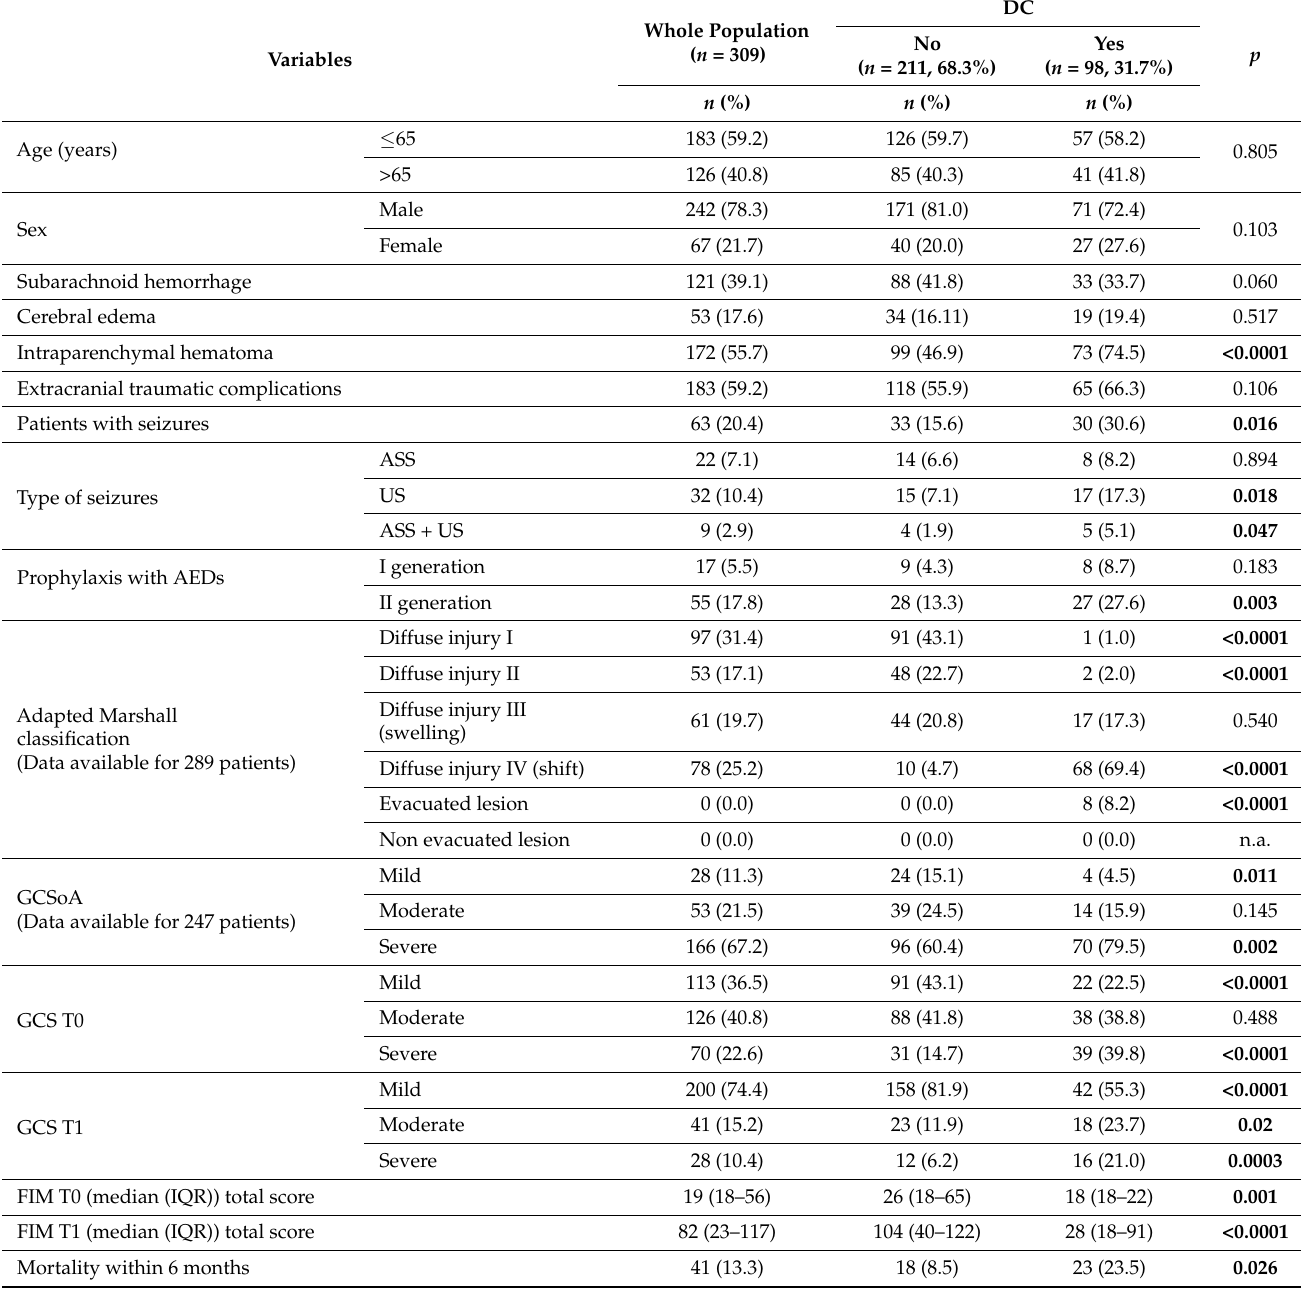
Table 1. Clinical and functional characteristics of the population as a whole and subdivided into two groups based on whether or not craniectomy surgery was